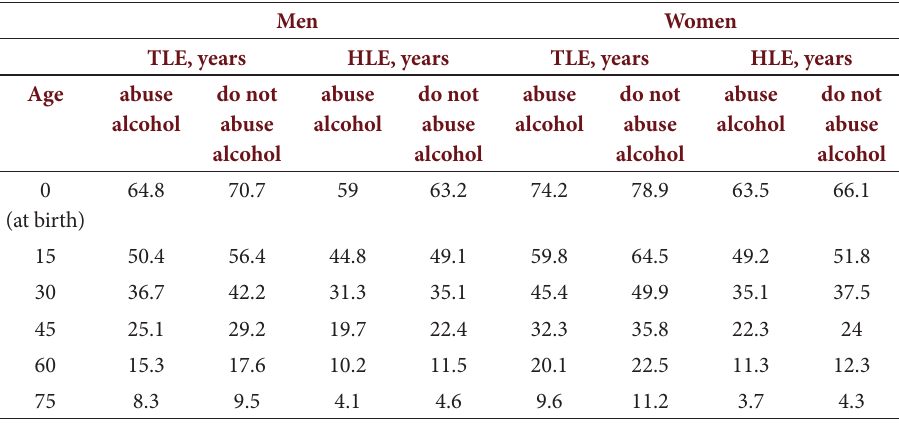
Table 4. HLE at various ages depending on alcohol consumption type,